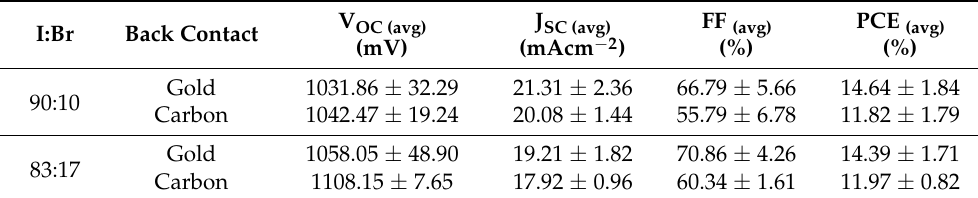
Figure 3. Statistics of PV parameters, namely J SC ( a ), V OC ( b ), FF ( c ), and PCE ( d ), of carbon-based solar cells with two different ratios of I: Br, 90:10 and 83:17. Table 2. The average PV parameters and standard deviations of the carbon- and gold-based devices with different halide ratios.